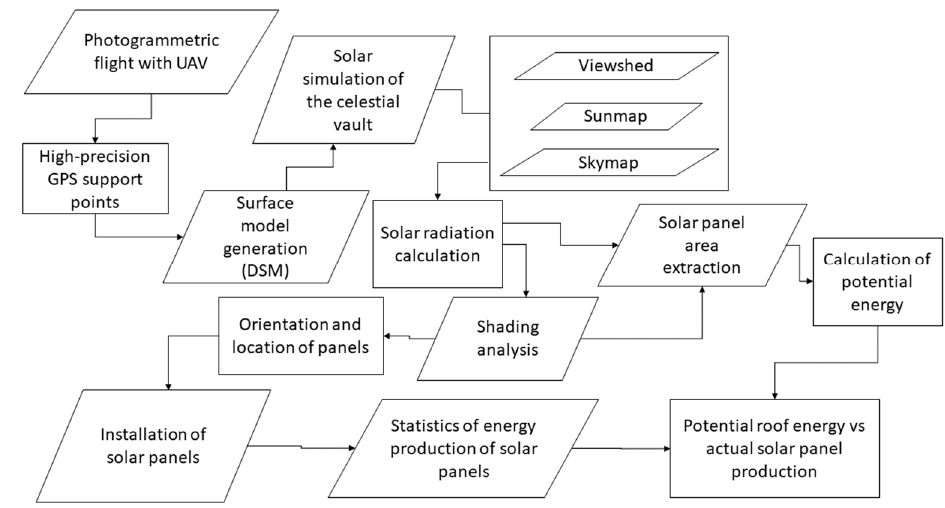
Figure 6. Flowchart of the unmanned aerial vehicles–digital surface model (UAV-DSM) method.